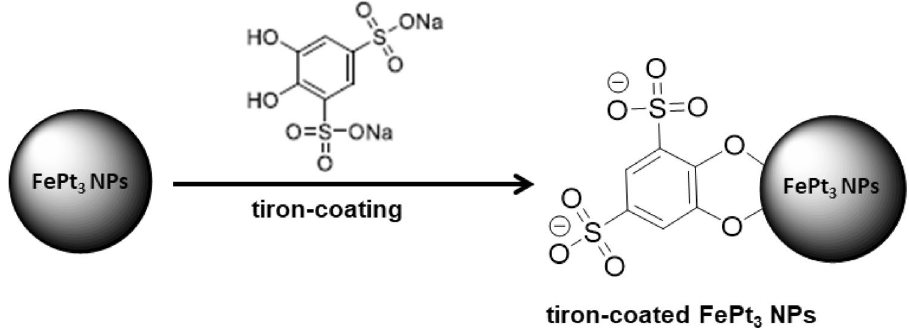
Fig. 5 Tiron-coating of the FePt 3